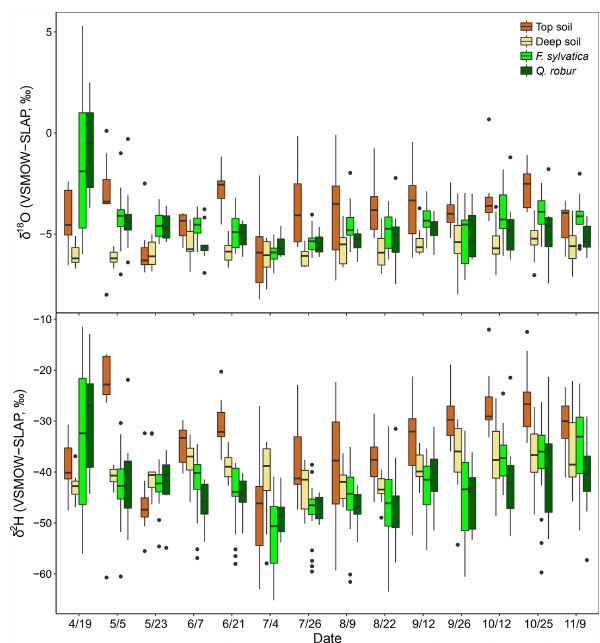
Figure 3. Isotopic composition of top soil water (0–10cm), deep soil water (50–120) and xylem water of the two studied species ( F. sylvatica and Q. robur ) for each sampling campaign. Data were pooled over the three studied plots. Box size represents the in- terquartile range, the black line is the median, the whiskers indi- cate variability outside the upper and lower quartiles, and individual points are outliers.